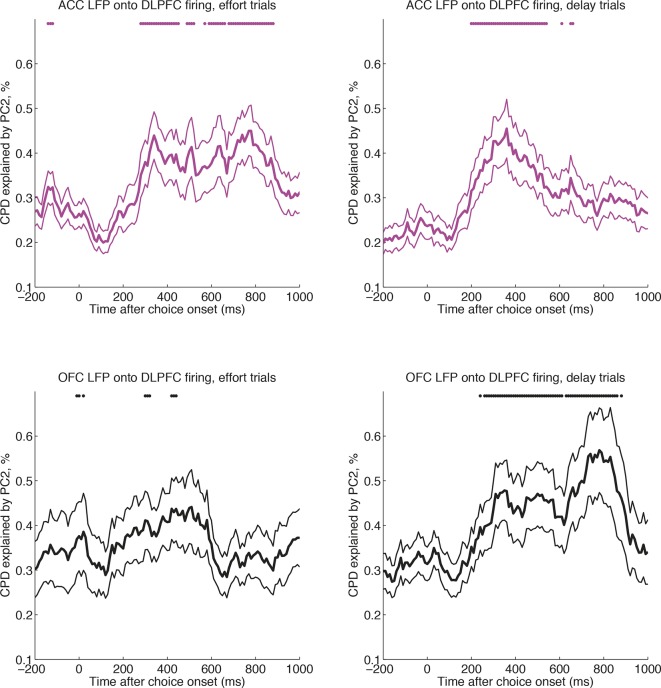
Cross-regional interactions, separately for delay versus effort trials.CPD for DLPFC firing explained by PC2 on effort trials (left) and delay trials (right), where PC2 is derived from simultaneously recorded ACC LFP (magenta, top row) and OFC LFP (black, bottom row) (n=124 DLPFC units, which had simultaneous recordings in both OFC and ACC). OFC and ACC PC2 weights compete for variance to explain neural activity in the same regression model (see Methods). Lines show mean /- s.e. across neurons. Dots denote timepoints with a significant (p<0.05, permutation test) change in CPD across the DLPFC population.